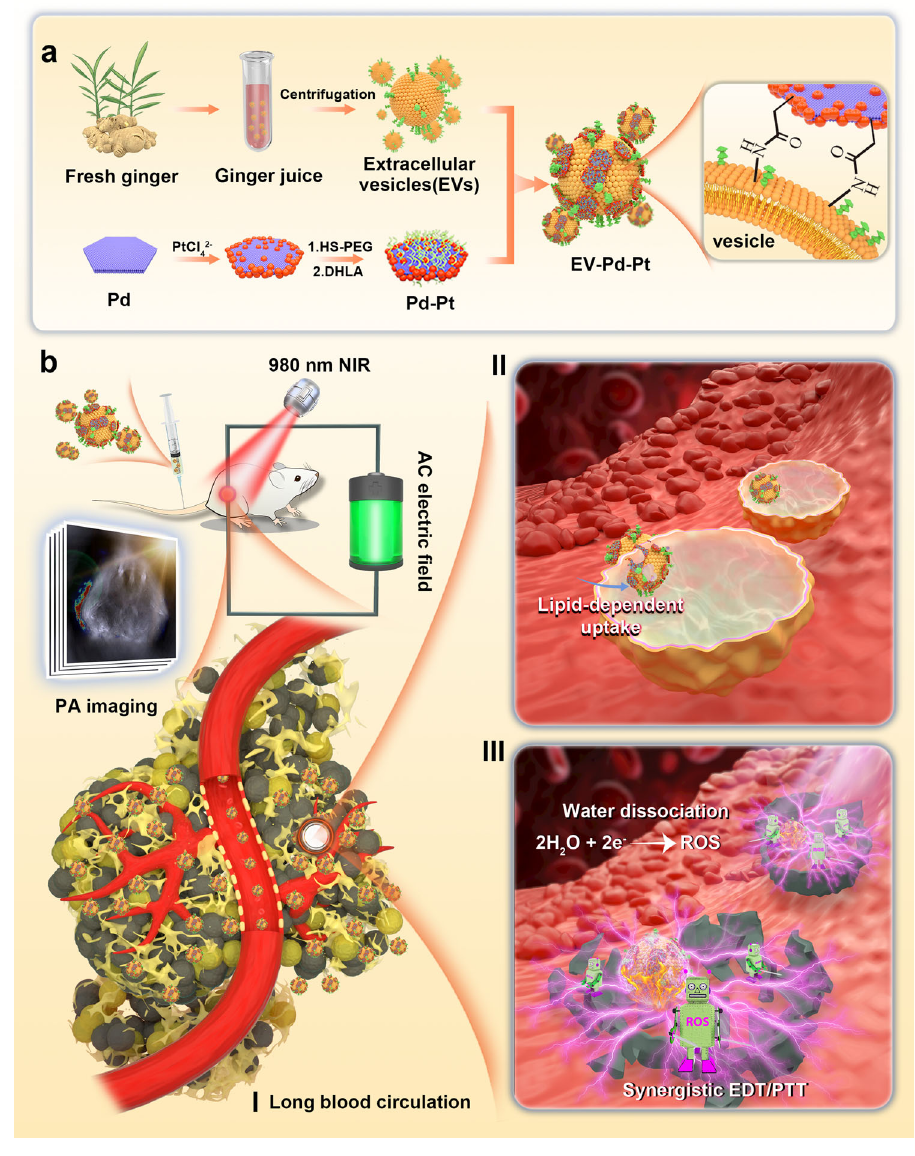
Fig. 1 | Schematic of the preparation of the EV-Pd-Pt nanoplatform and its antibacterial application. a Schematic illustration of the preparation of EV-Pd-Pt nanoparticles by conjugating carboxylic group-functionalized Pd-Pt nanoparticles ontothesurfaceofginger-derivedEVswithabundantaminogroups. b PAimaging-